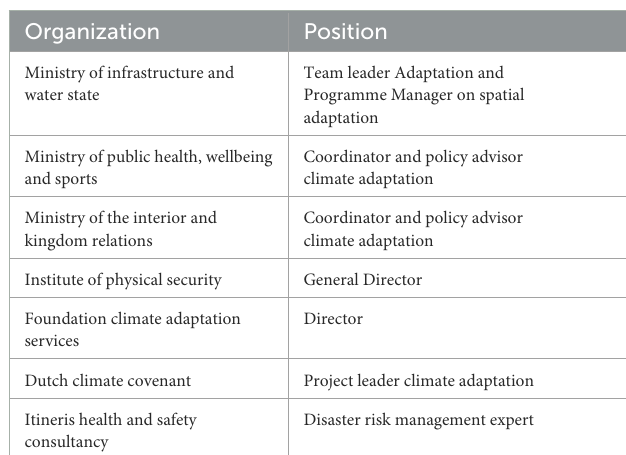
TABLE 3 Selected respondents